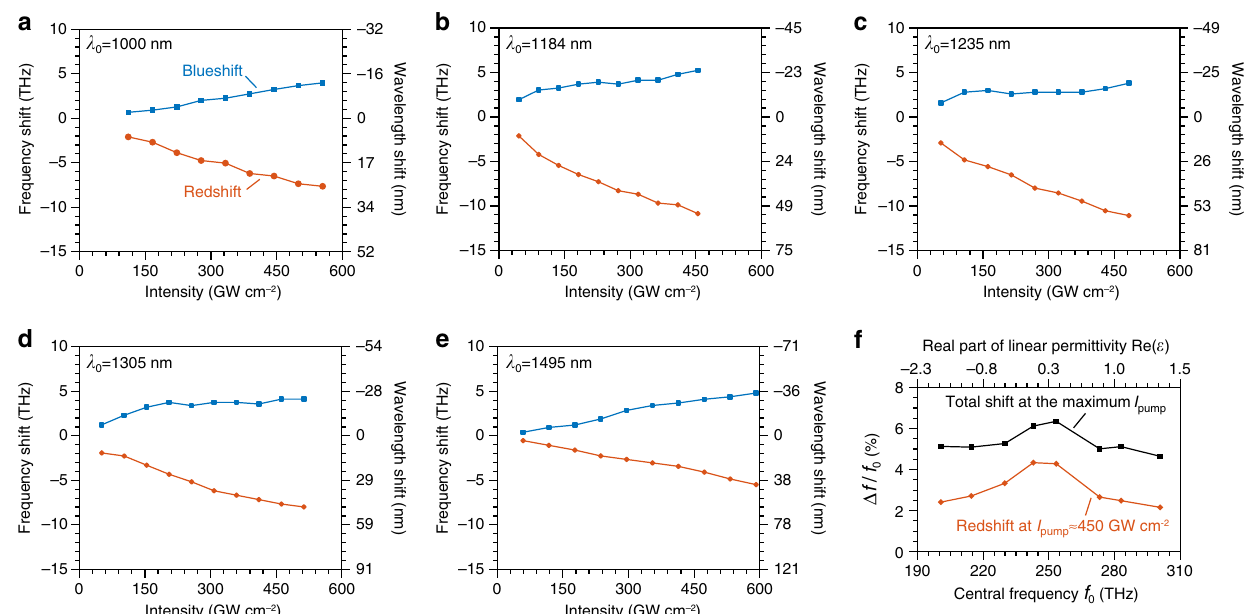
Fig. 4 Wavelength-dependent time-refraction effect. a – e Experimentally measured maximum redshifts and blueshifts at different wavelengths λ 0 as a function of peak pump intensities. f The red line denotes the fractional redshift | Δ f red |/ f 0 as a function of probe beam ’ s central frequency f 0 at a peak pump intensity ~450 GW cm − 2 . The real part of the linear permittivity Re( ε ) of ITO fi lm at the corresponding central frequency f 0 is shown in the top axis. The black line shows the total fractional shift (redshift plus blueshift) measured at the maximum pump intensities before the onset of higher-order nonlinear optical effects. We fi nd that both the maximum fractional redshift and the total shift occur near the zero-permittivity